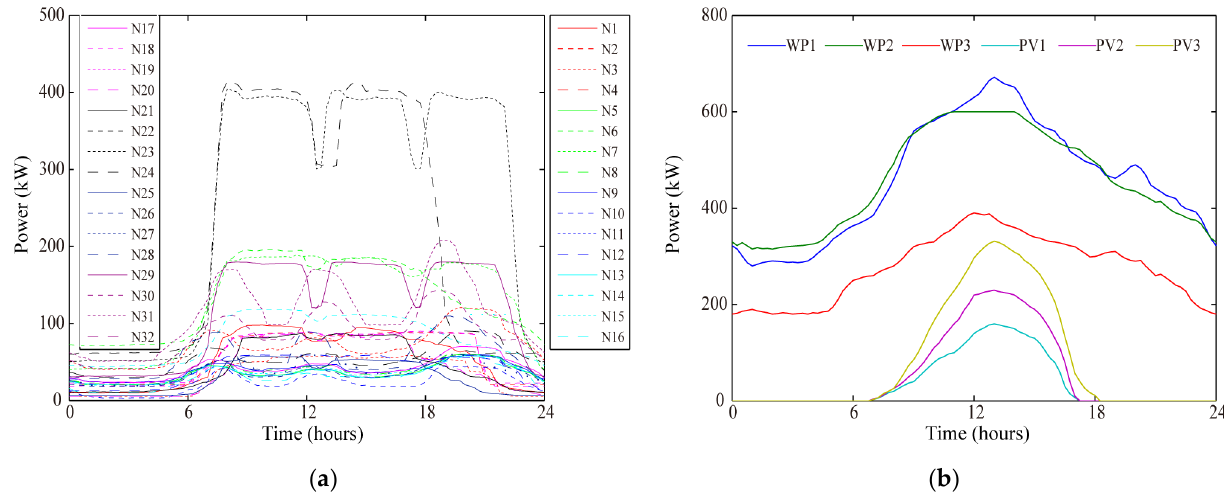
Figure 9. ( a ) Power consumption dispatching orders of the power users; ( b ) Distributed generation dispatching orders.